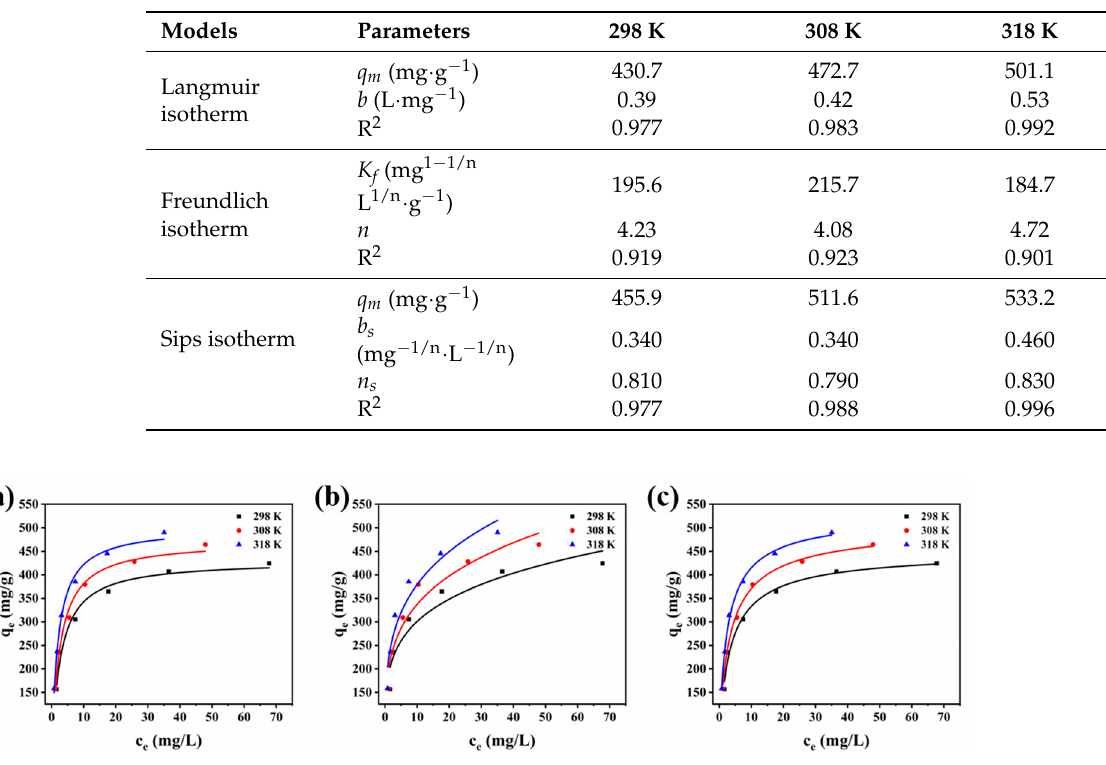
Figure 6. Adsorption isotherms of TC adsorbed by Alg-Cu@GO@MOF-525: ( a ) Langmuir model, ( b ) Freundlich model, and ( c ) Sips model.